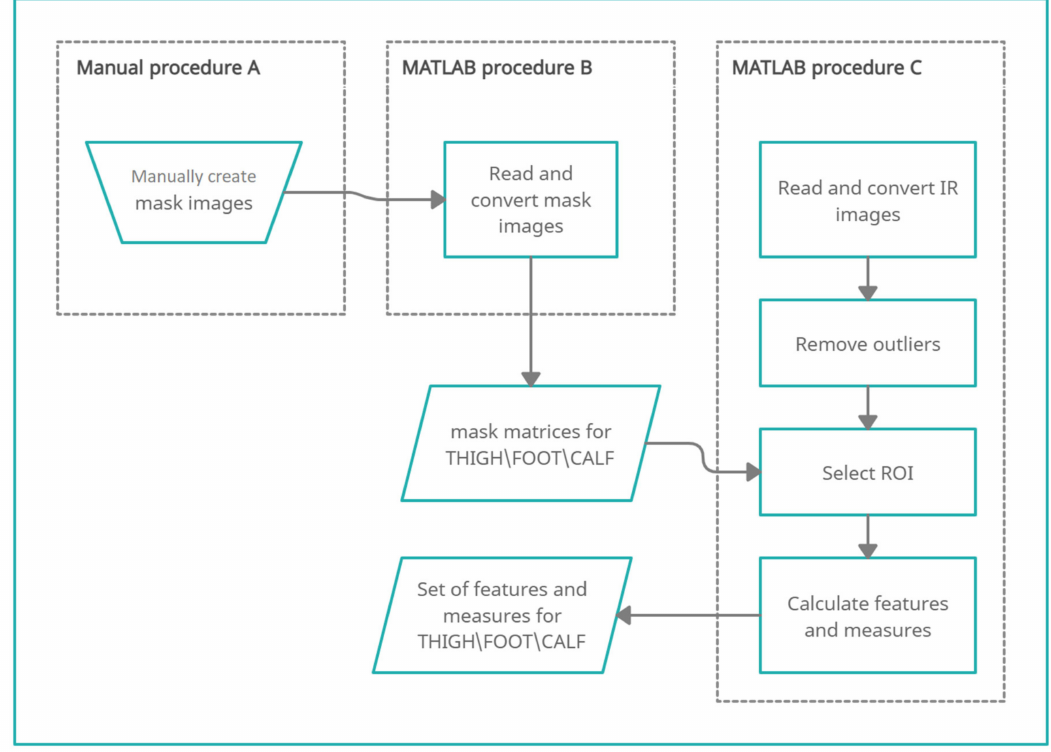
Figure 3. A general flow chart of the procedure for the feature and measure calculations performed in the MATLAB